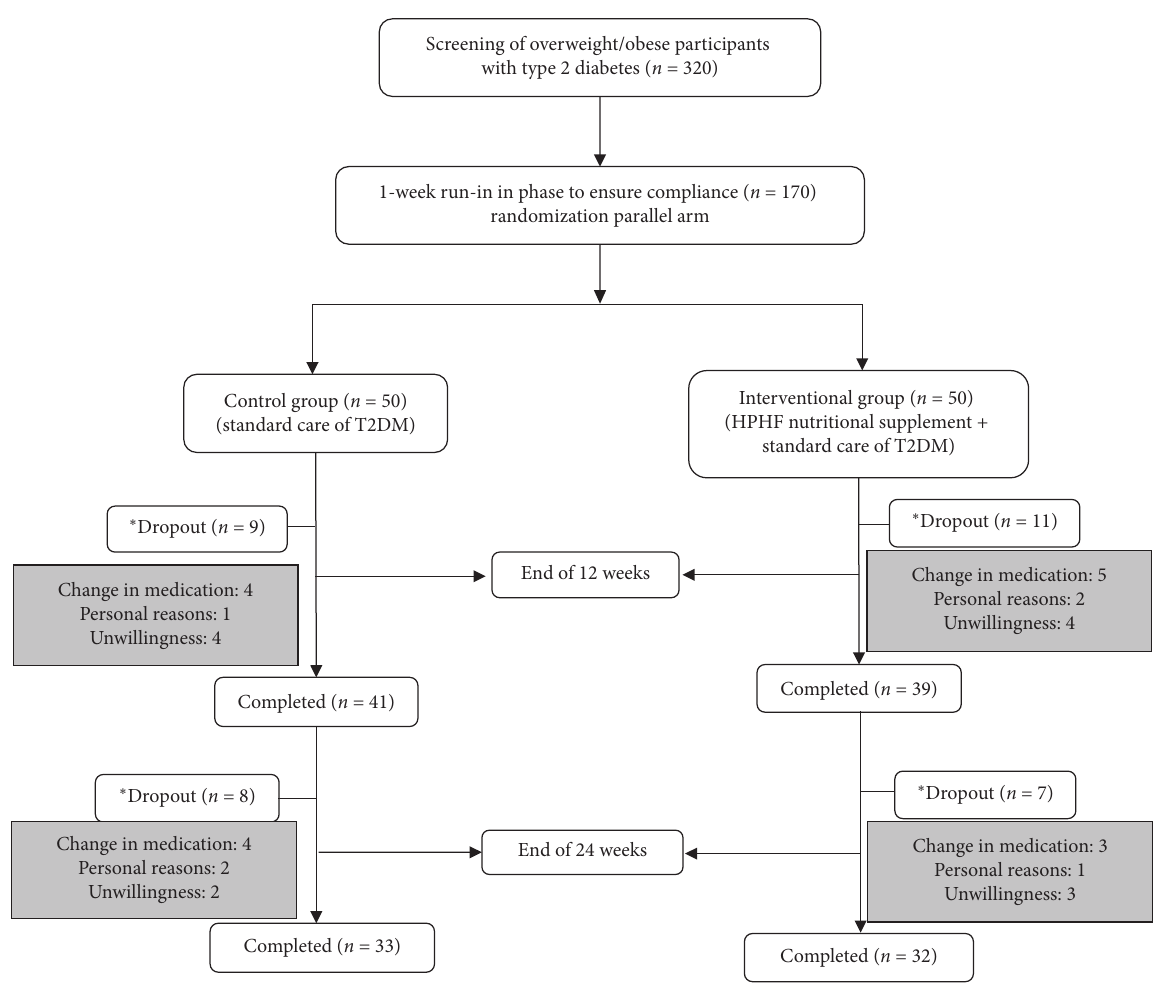
Figure 1: Study design. Note: a one-week run-in phase was performed before randomization to ensure compliance of participants enrolled in the study. Lipid profile was carried out at baseline (first 15 days), interim visit (15 days at the end of 12 weeks), and end of the study (15 days at the end of 24 weeks). For dietary compliance assessments, average of 5 recalls were collected during the 24 weeks’ intervention and compared to baseline (3 days of dietary recall at baseline). ∗ Total dropouts ( n � 35): reasons include lack of response or unwillingness to continue the study, personal reasons (such as out-of-station travel and family function), and change in diabetes